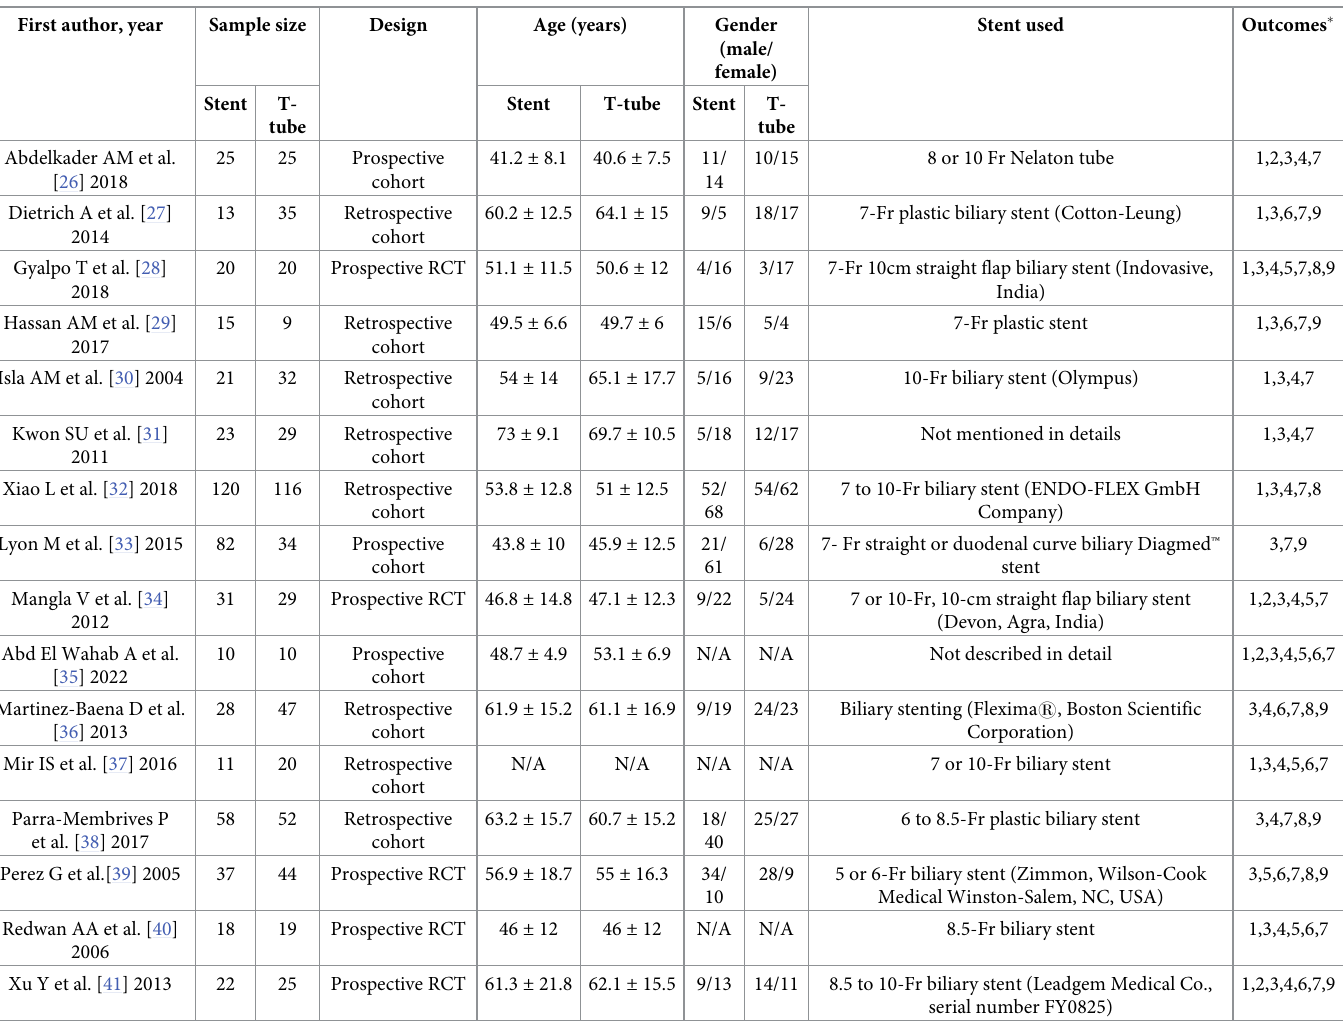
Table 1. Data characteristics of the included